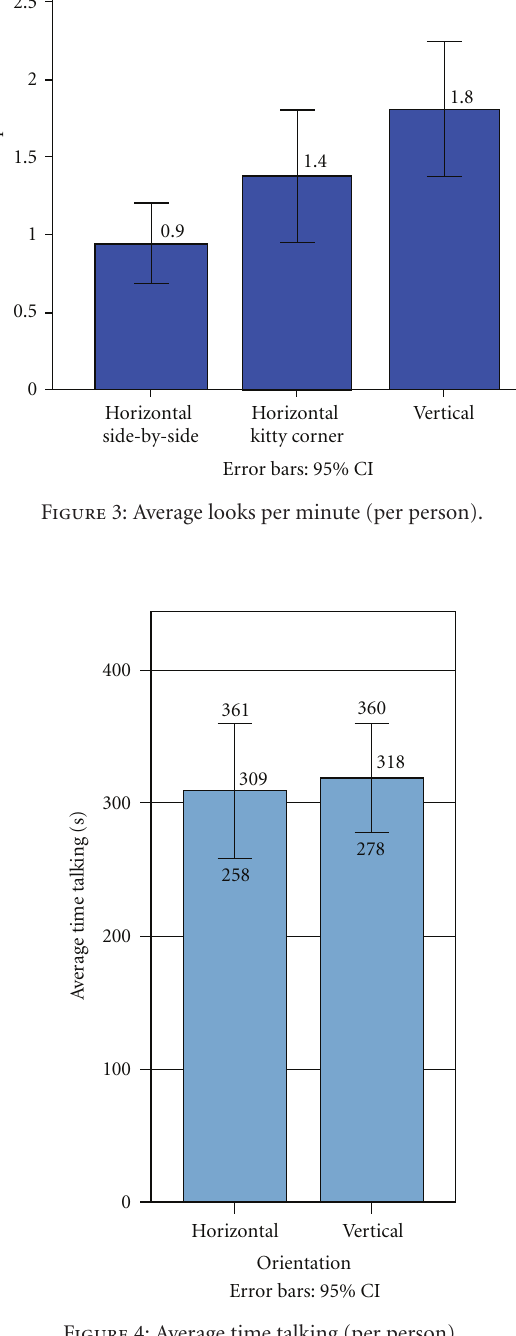
Figure 4: Average time talking (per person).